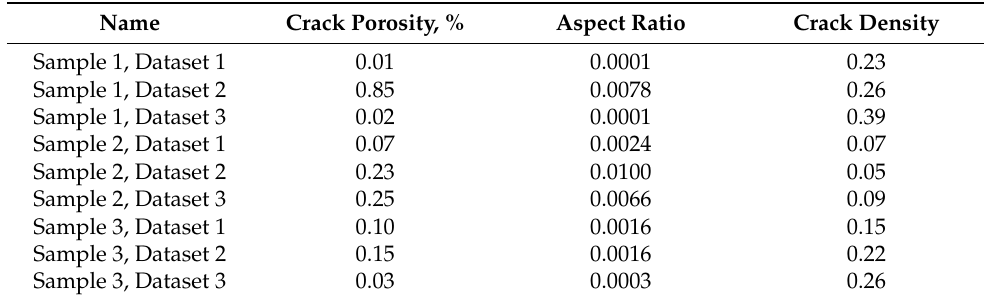
Table 2. Microcrack parameter corresponding to the most probable solutions.